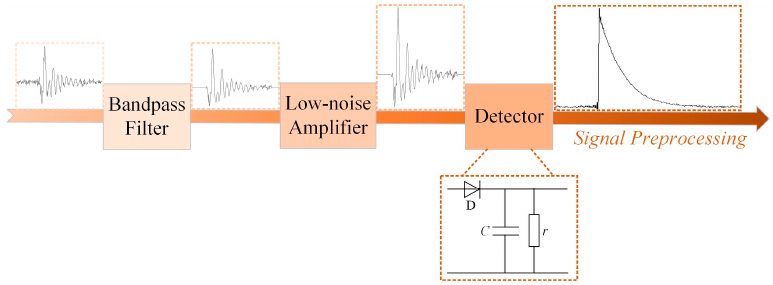
Figure 9. TEV Signal preprocessing procedure.